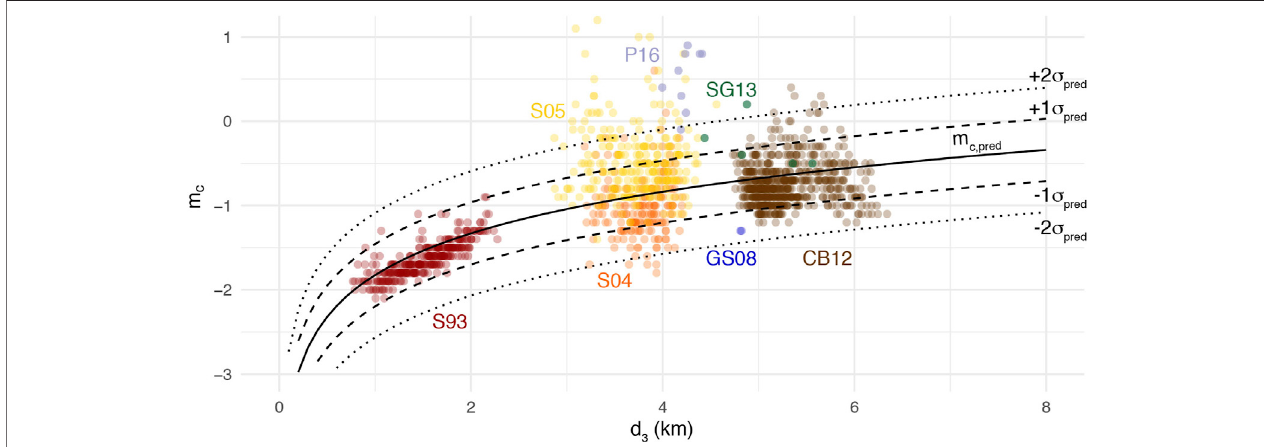
FIGURE4| Priormodel m c , pred (cid:1) f ( d 3 ) oftheBayesianMagnitudeofCompleteness(BMC)methodforthethree-dimensionalinducedseismicitycasewithdistance d 3 to the third nearest seismic station.